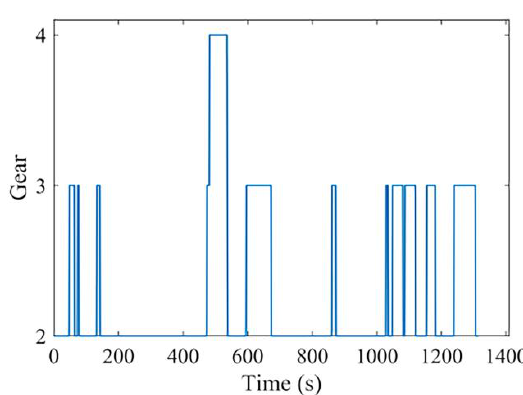
Figure 24. Gear of the shift schedule based on RL.